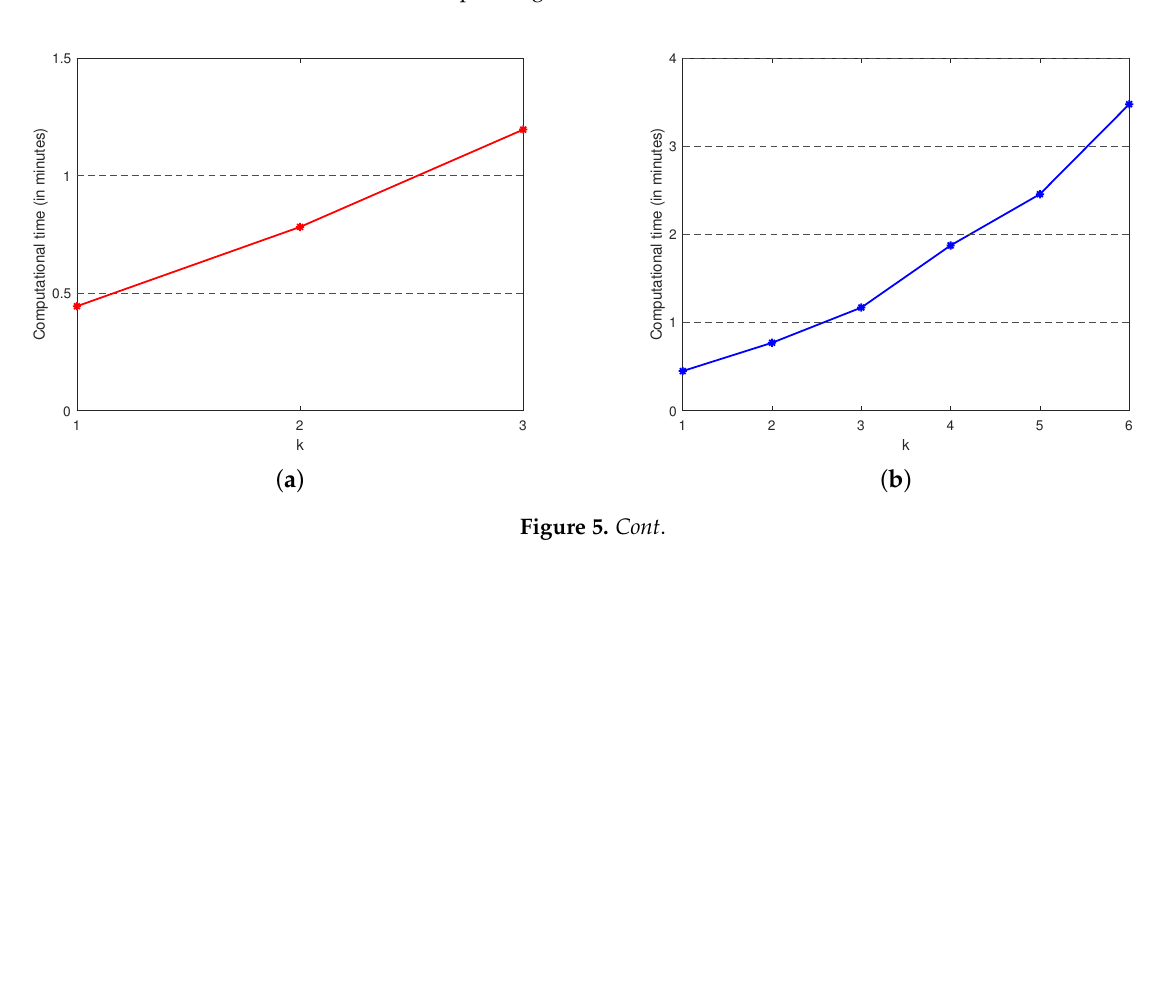
Figure 4. Average CR of 10,000 matrices vs. number of missing comparisons k with respect to the matrix size n corresponding to Table 5.